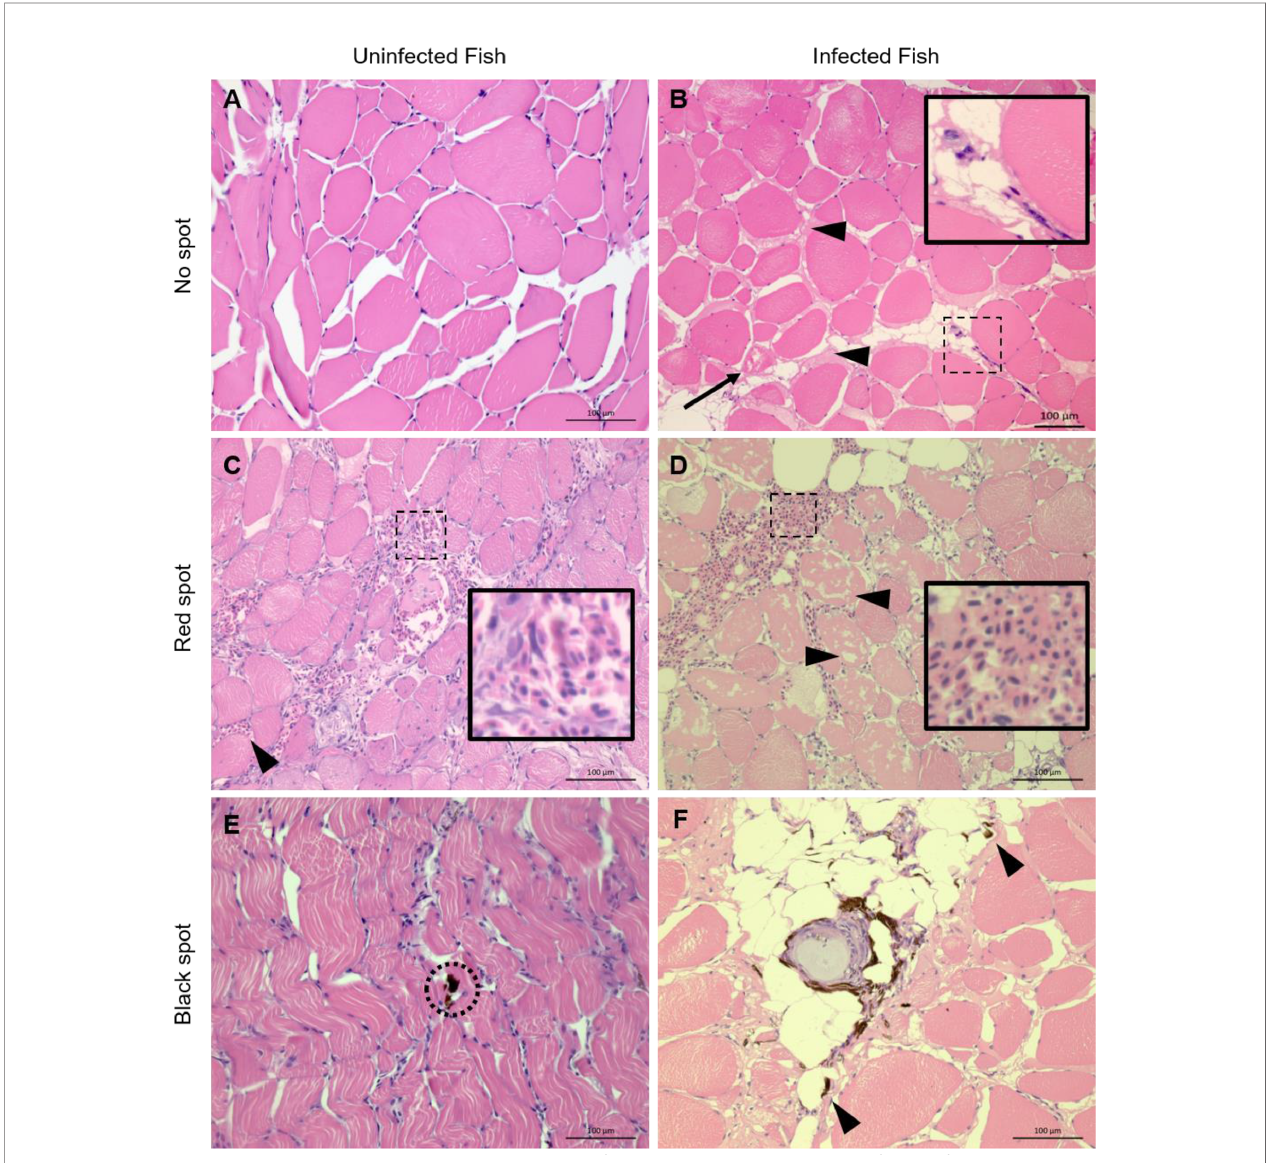
FIGURE 1 | Representative histological sections from white skeletal muscle of noninfected and PRV-1 infected Atlantic salmon HE stained. (A) Myocytes with no observable changes. (B) Myocytes with mild degeneration (arrow) and presence of inter-myocytial fl uid (arrowheads) and few in fi ltrating leukocytes (inset). (C) Uninfected fi sh, red focal change shows areas with moderate (inset) and minor (arrowhead) hemorrhages. Note minor degeneration in some myocytes with in fi ltrating macrophages. (D) Red focal change in PRV-1 infected fi sh with large hemorrhage (inset) and massive myocyte necrosis (arrowheads). (E) Black spot in uninfected fi sh. Sporadic occurrence of melano-macrophages (black) in seemingly otherwise non-affected tissue (dotted circle). (F) Black spot in infected fi sh with a typical granulomatous change surrounded with melano-macrophages (black). Arrowheads point to scattered melano-macrophages. Scale bar = 100